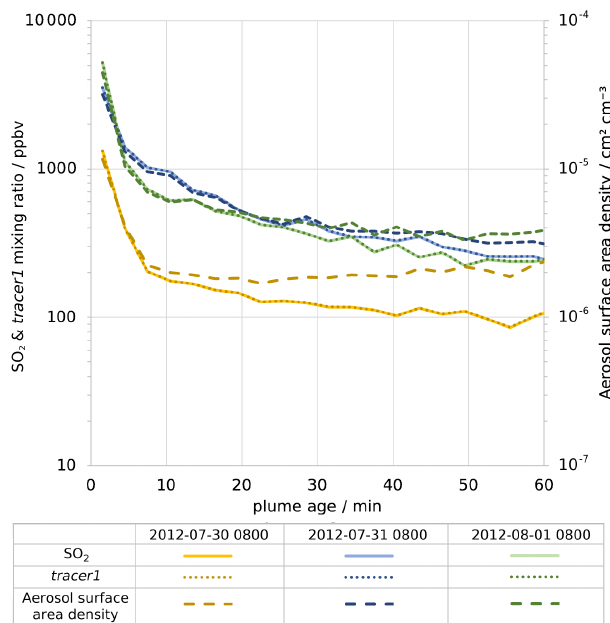
Figure 6. Modelled average in-plume mixing ratios of, on left axis, SO 2 (solid lines) and tracer1 (dotted lines) and, on right axis, den- sity of aerosol surface area (dashed lines). Values are plotted against plume age for 08:00UTC for 30 July 2012 (yellow), 31 July 2012 (blue), and 1 August 2012 (green). Note that both y axes are loga-